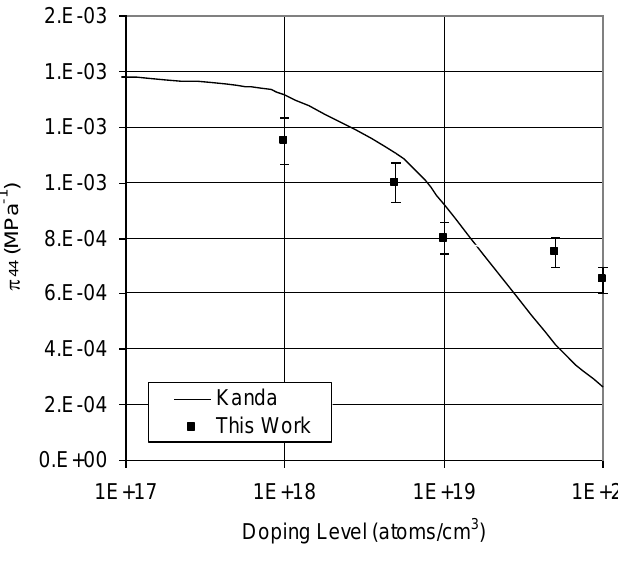
Figure 27. Comparison between experimental values of  room